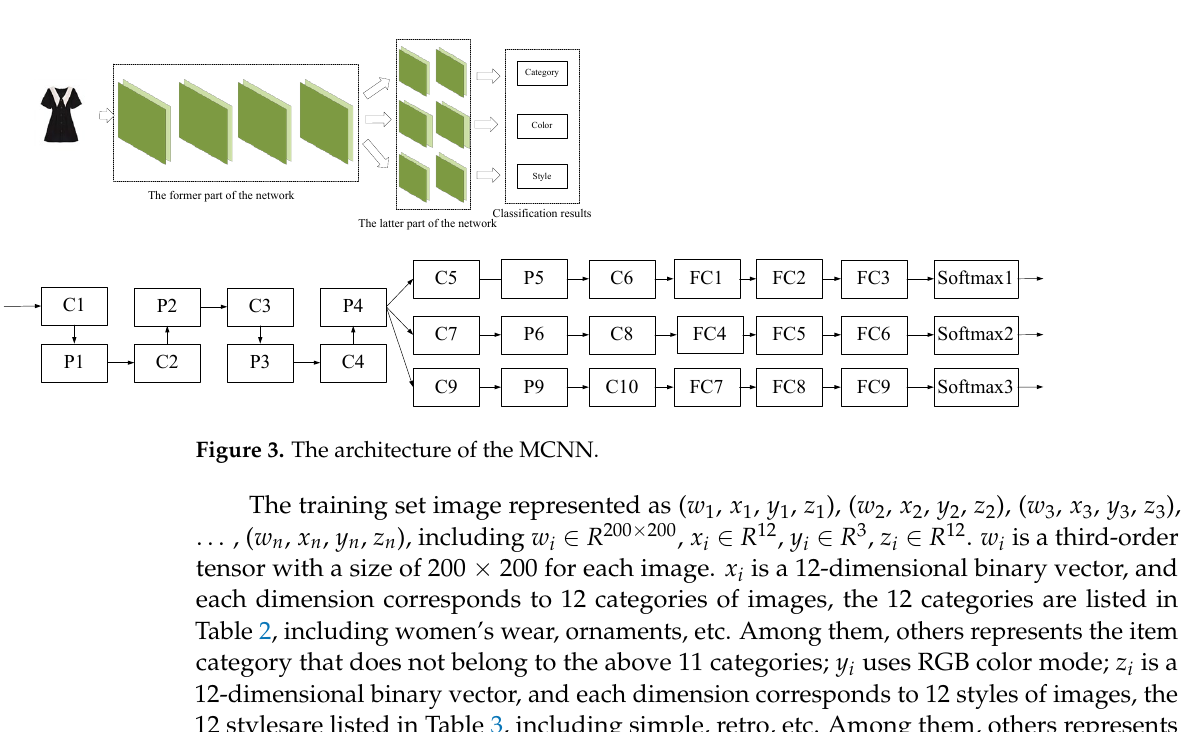
Table 2. Category one-hot encoding form.